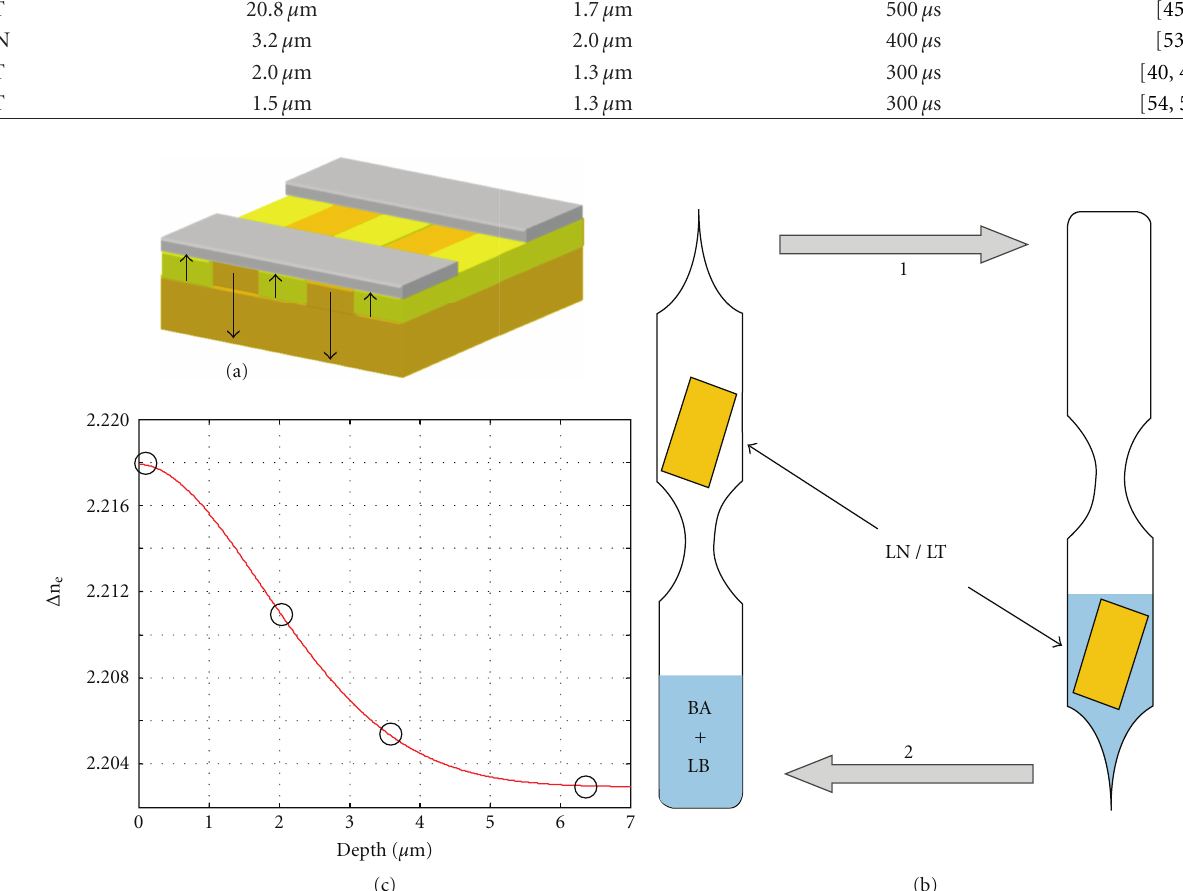
Figure 5: (a) Channel waveguide in a PPLN/PPLT sample. (b) Sealed ampoule technique. (c) Extraordinary index profile calculated by inverse WKB from distributed coupling data; dots are measured e ff ective indices at 632.8 nm, and the solid line is a WKB